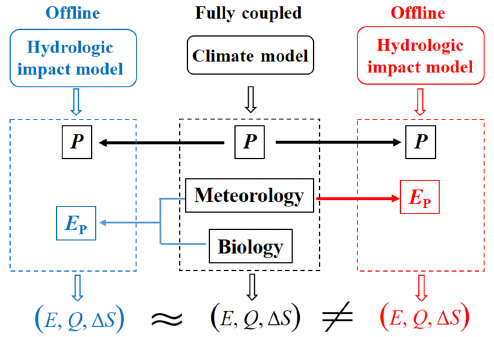
Figure 1. Conceptual plot illustrating the inconsistency in the hy- drologic predictions between climate models and offline hydrologic impact models. The symbols P , E P , E , Q , and (cid:49)S represent pre- cipitation, potential evapotranspiration, actual evapotranspiration, runoff, and storage change, respectively. The meteorological vari- ables used to calculate E P depend on the adopted E P model, but mainly include net radiation, near-surface air temperature, vapor pressure, and wind speed. The biological factor here is the response of surface resistance to elevated [CO 2 ] over vegetated